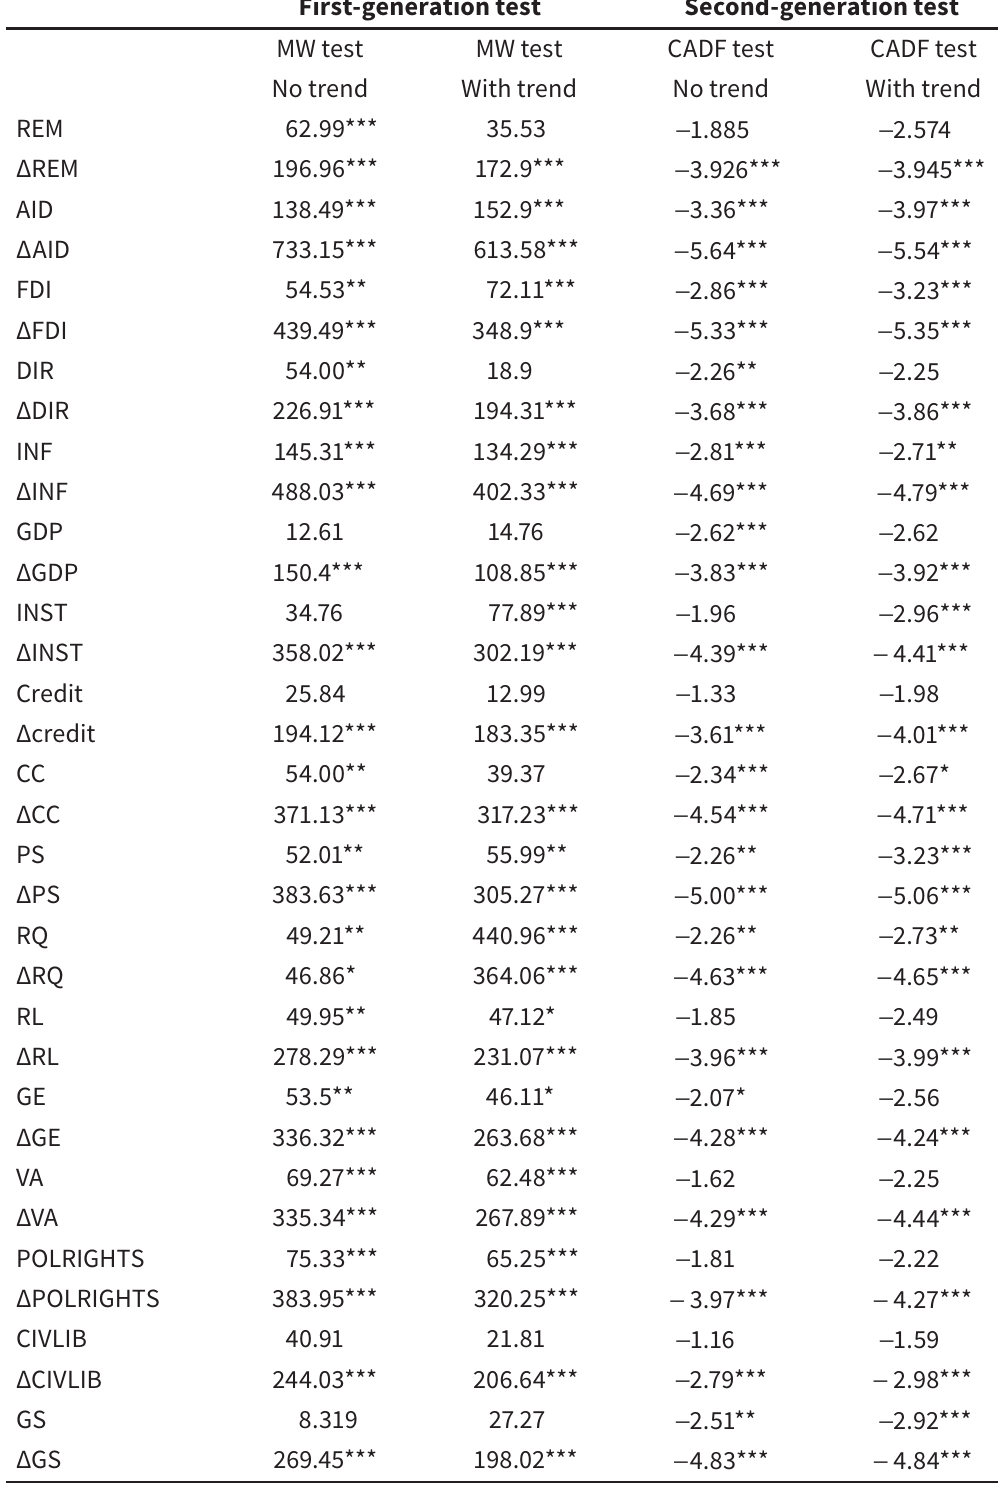
Table 8 Panel unit root tests – first and second generations First-generation